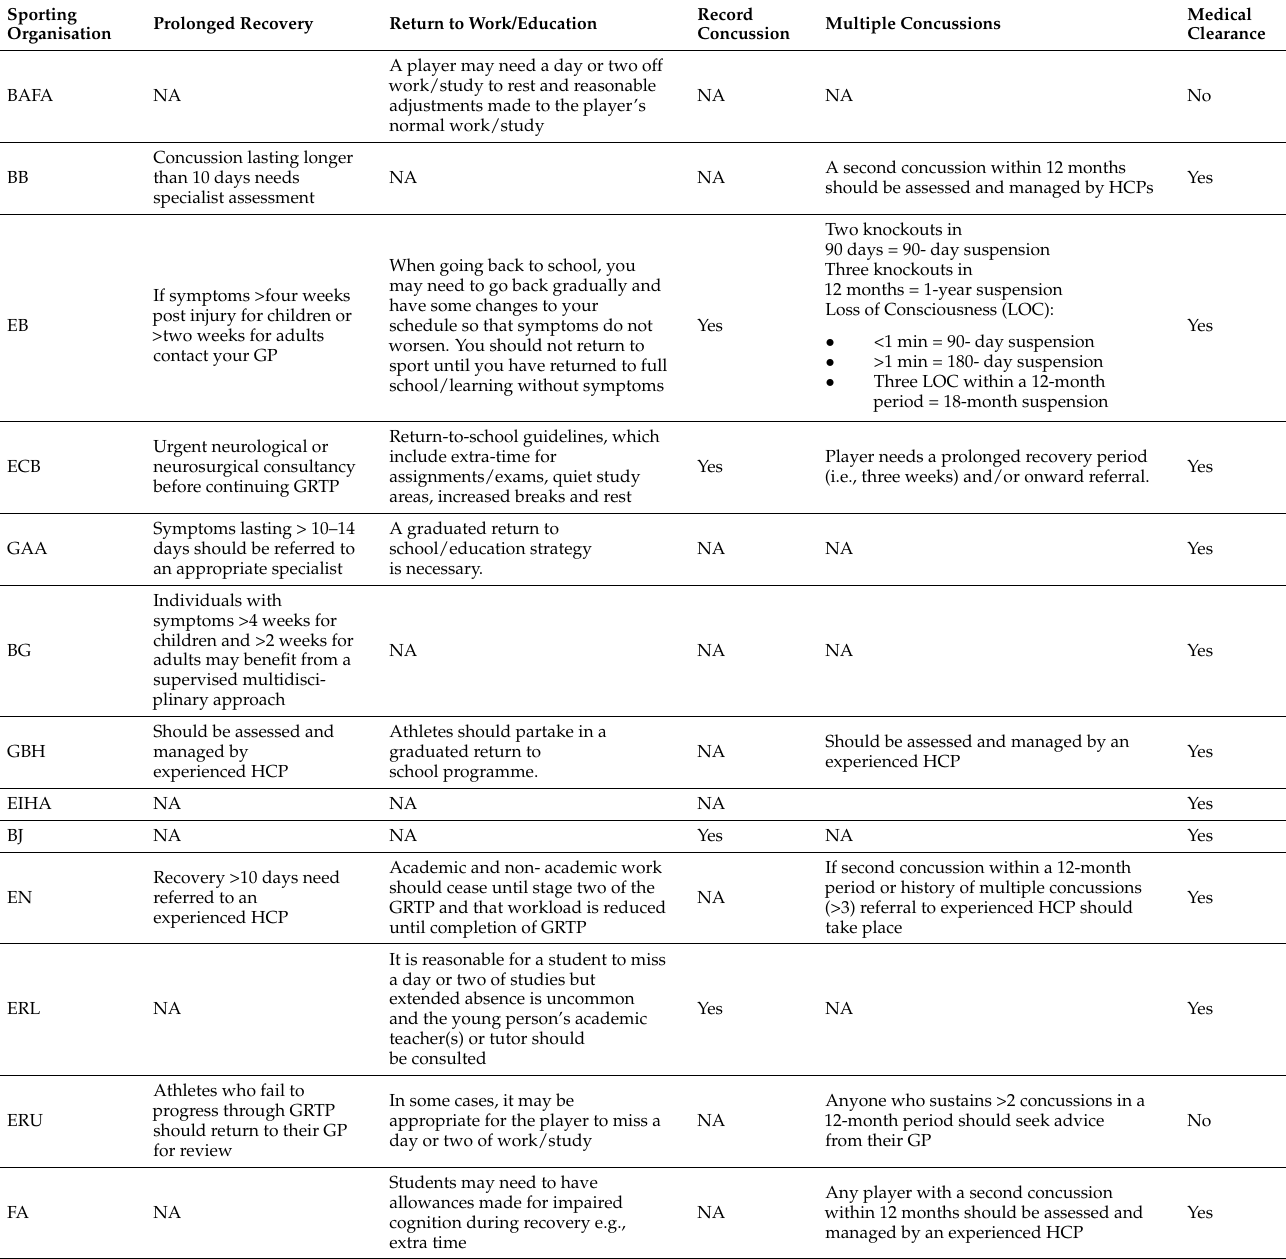
Table 3. Summary of SRC guidelines published by UK sporting organisations